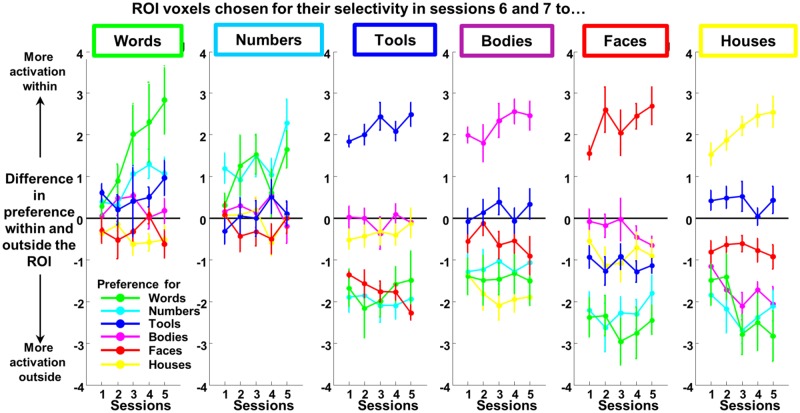
Evolution of responses in left-hemispheric voxels that ultimately specialize for a given category.For each child, we subdivided left ventral temporal voxels into the ROI formed by those selective for a given category during the final sessions 6 and 7 (category > others, p < 0.001) and the remaining voxels. We then went back in time and asked how these 2 sets of voxels differed in their responsivity to the various categories of stimuli in the preceding sessions 1–5. Each plot shows the difference in activation evoked by a given stimulus (e.g., words) relative to other categories (excluding words), in voxels within and outside the specified ROI. For instance, the green curve at left indicates that word-selective voxels in sessions 6 and 7 showed no specificity for words during sessions 1 and 2 (values not different from 0) but became selective in sessions 3, 4, and 5 (positive values). Therefore, there is a clear emergence of selectivity for words in RR voxels. The fact that other (nongreen) curves in this panel are indistinguishable from 0 indicates that the VWFA voxels cannot be anticipated by their responsivity to other categories. By contrast, voxels selective to tools, houses, faces, or bodies in sessions 6 and 7 already exhibit their category specificity in the very first sessions. S3 Data. ROI, region of interest; RR, reading-related; VWFA, visual word form area.